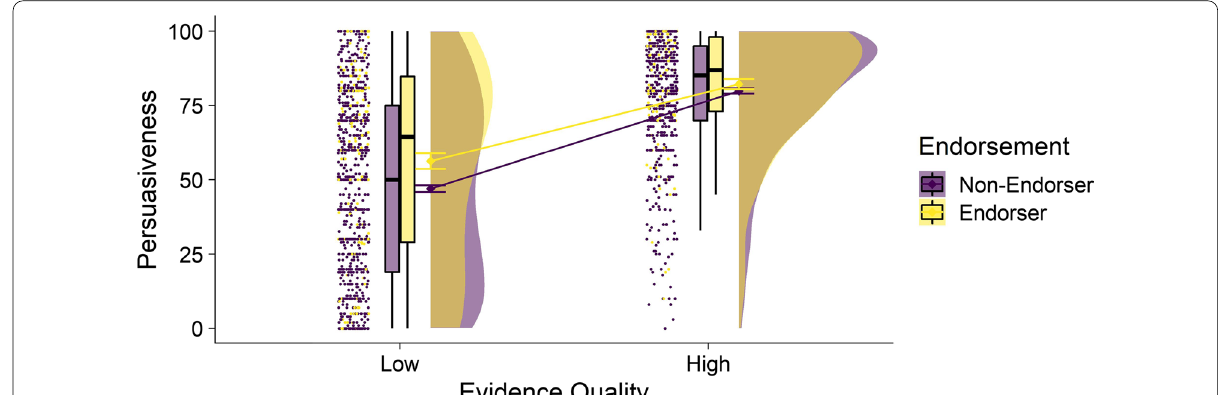
Fig. 1 Persuasiveness Ratings for Endorsers and Non‑Endorsers by Evidence Quality ( N raw jittered data points; (2) Box‑and‑Whisker plots with median (middle bar), first and third quartiles (boxes either side of bar) and no further than 1.5 the interquartile range (whiskers); (3) means (diamonds) and 95% confidence intervals (error bars);(4) distributions showing the frequency of ×